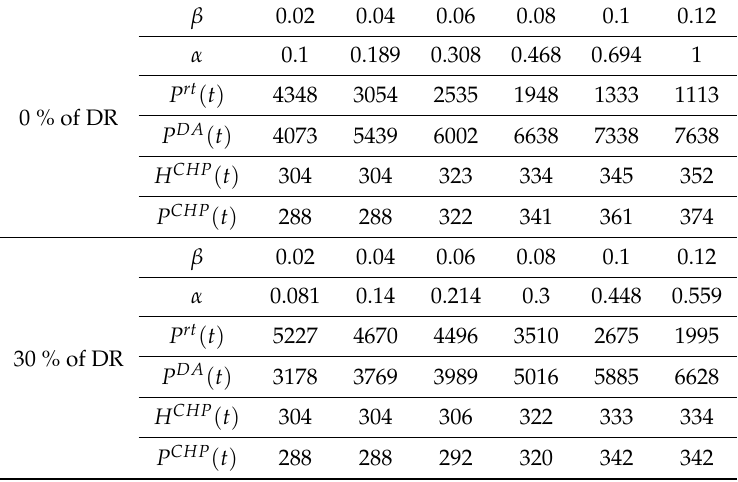
Table 3. A sensitivity analysis on β and the DR